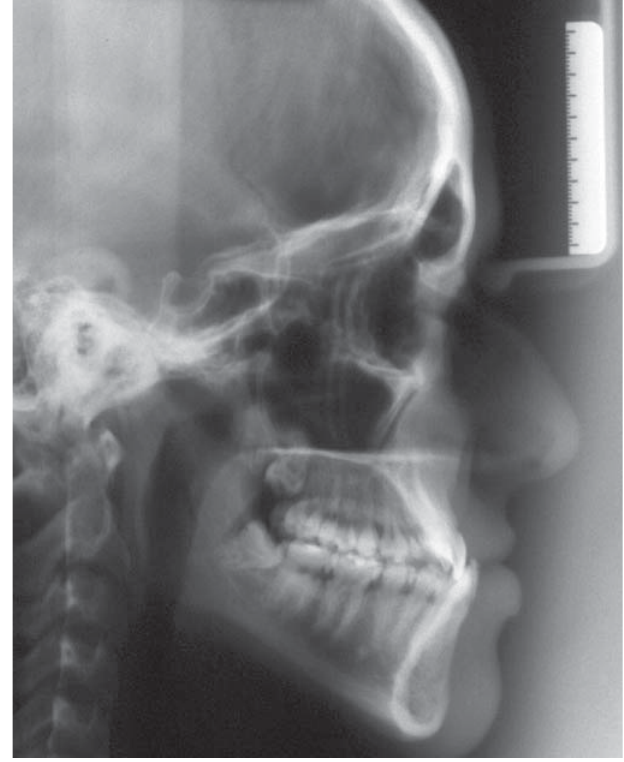
FIGURE 3- Pretreatment cephalometric